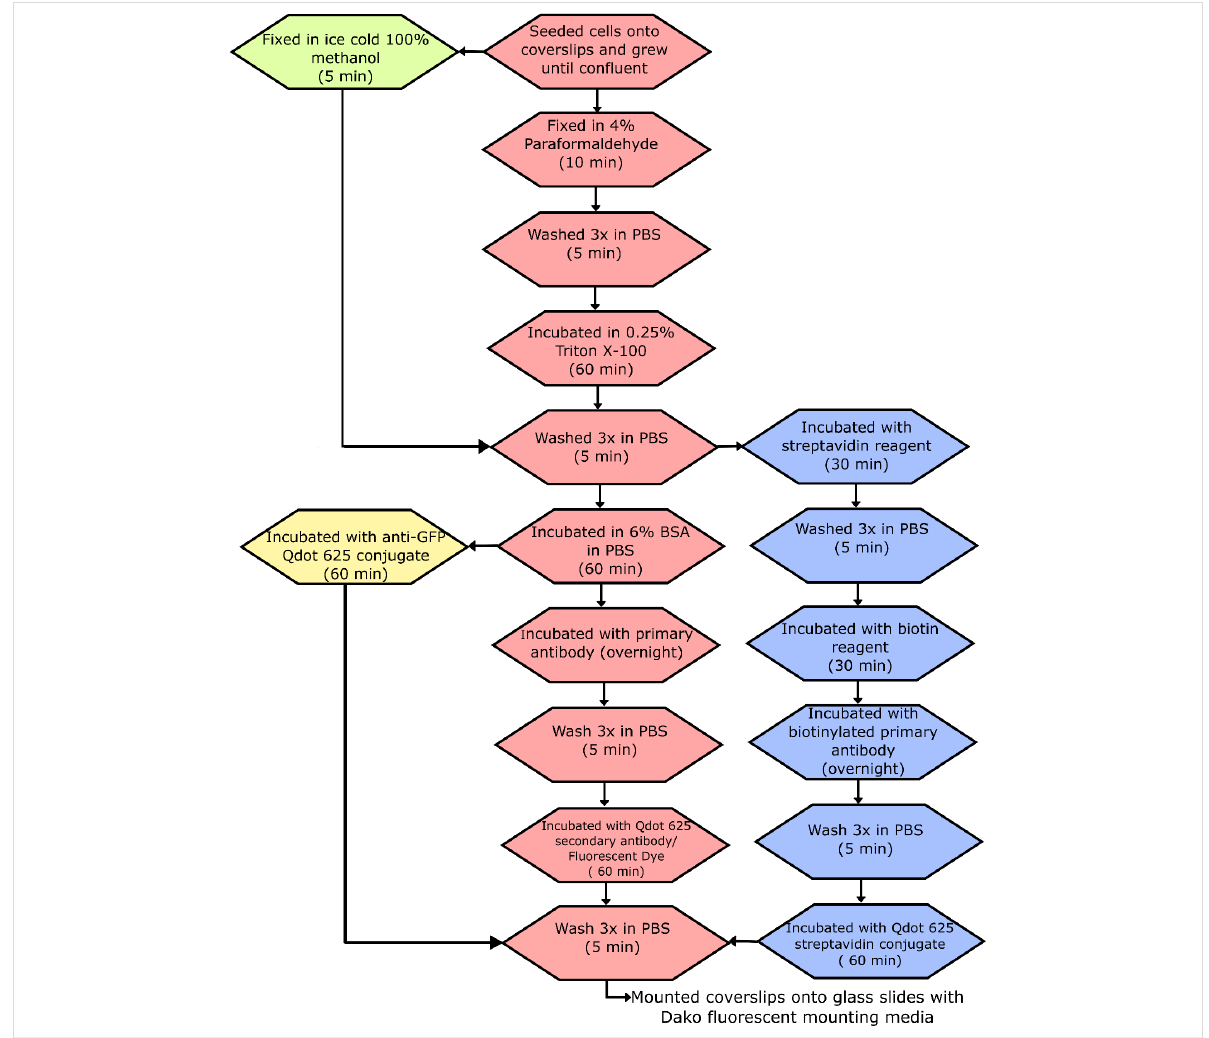
Figure 8: Immunofluorescence protocol. The pink boxes show the method for use with a primary antibody and Qdot 625/Fluorescent dye conjugated to a secondary antibody, green box is for methanol fixation, yellow boxes for the anti-GFP Qdot 625 conjugate, and blue boxes are for biotinylated pri- mary antibody with Qdot 625 streptavidin